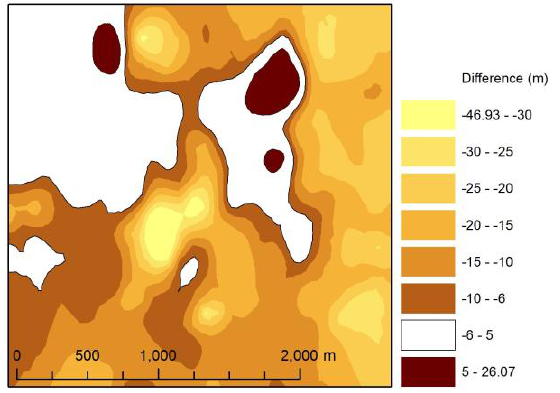
Figure 4. Atlanta International Airport: the map of the SRTM elevation anomalies. The hollow areas represent differences in elevation within a range of statistically acceptable disparities.